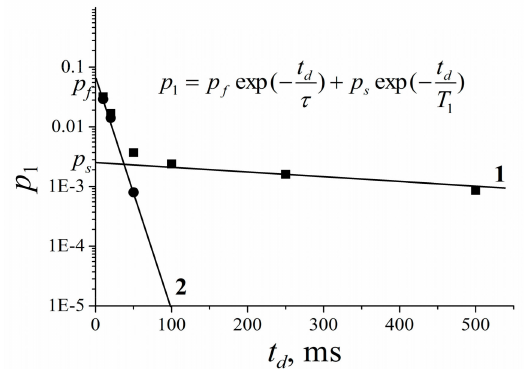
Figure 64. (1) the dependence of intracellular water population p 1 ( t d ) on diffusion time t d . (2) The dependence p 1 ( t d ) after subtraction of spin–lattice relaxation part. Temperature is 35 ◦ C. Reprinted with permission from [171]. Copyright 2016 Springer Nature.